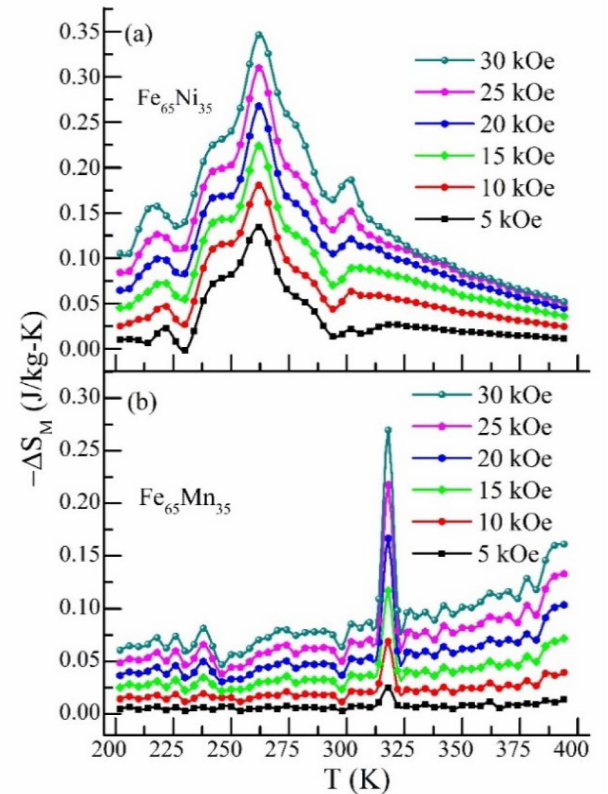
Figure 5. Temperature response of isothermal magnetic entropy change ( ∆ S M ) at different applied field: ( a ) ∆ S M vs. T curve for Fe 65 Ni 35 ; ( b ) ∆ S M vs. T curve for Fe 65 Mn 35